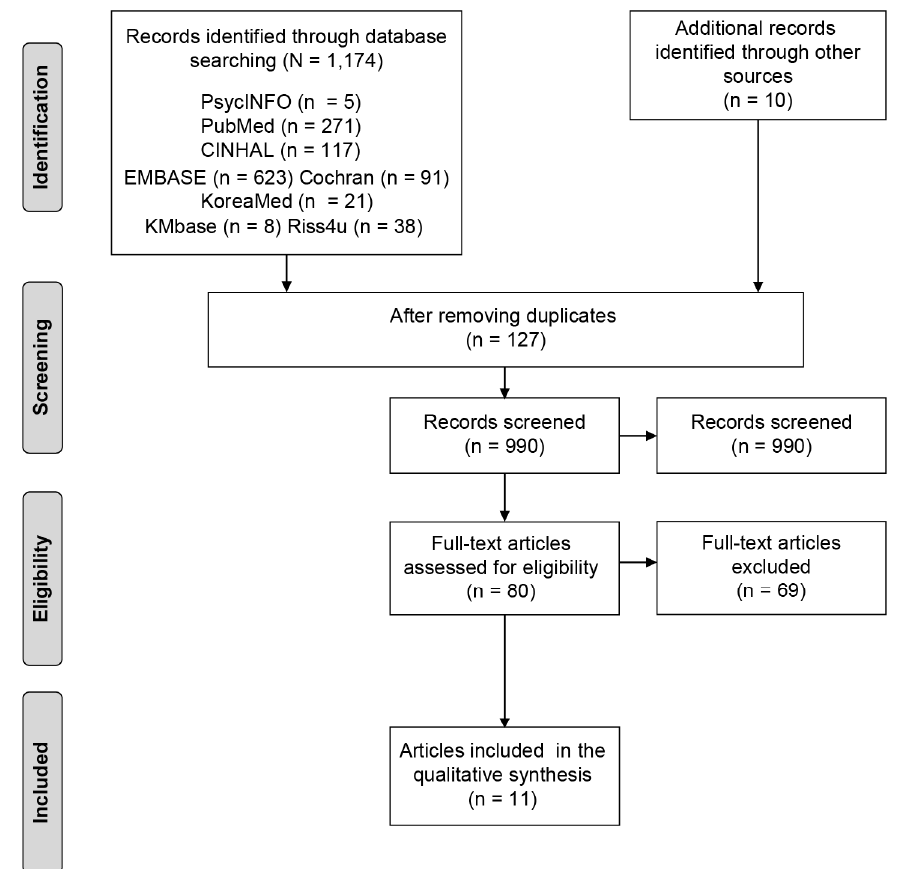
Figure 1. Flow diagram of study selection.